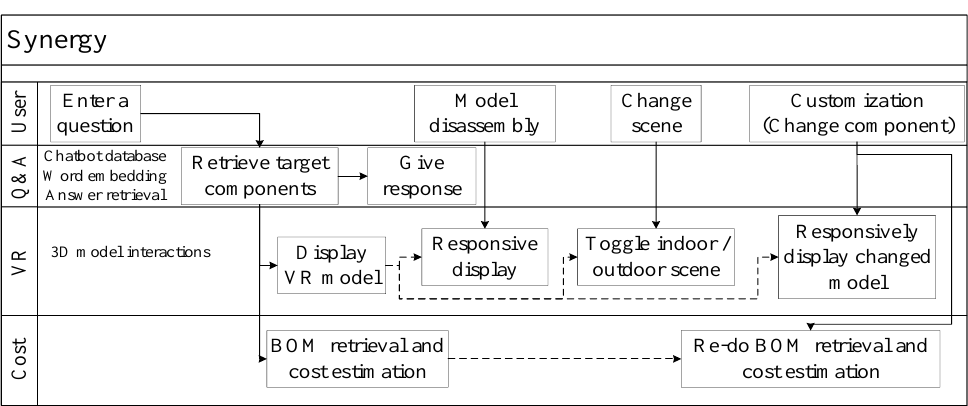
Figure 8. Synergy of the proposed integrated chatbot system.